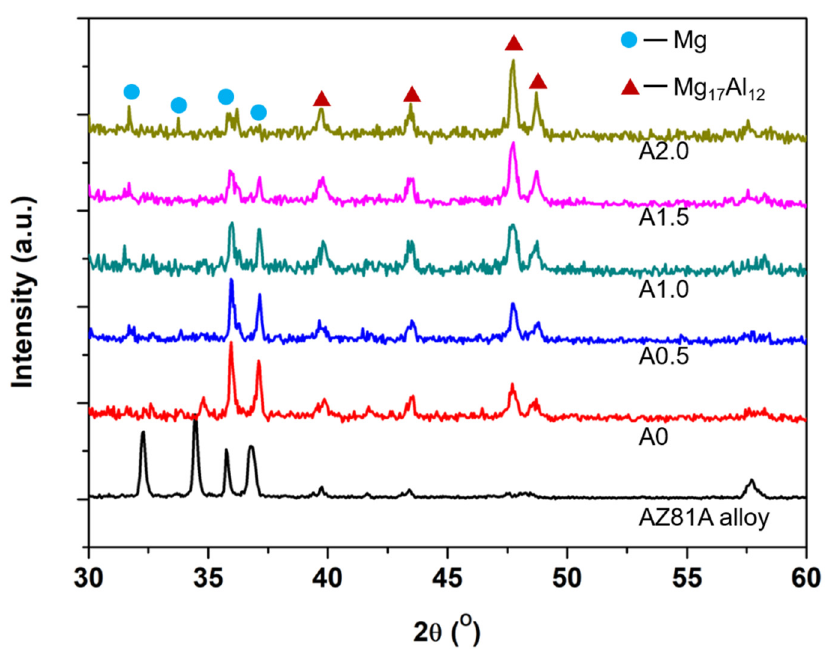
Figure 4. XRD patterns of the based AZ81A alloy and weld seam profiles cladded with different oscillating